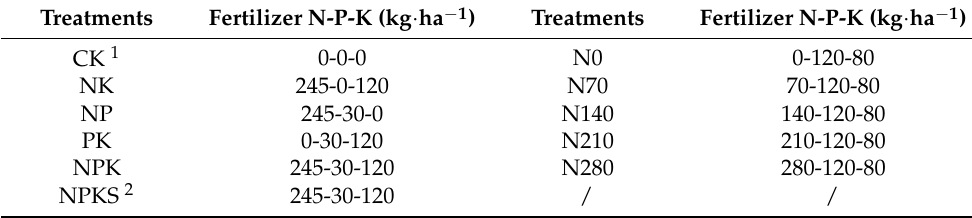
Table 1. NPK nutrient treatments in the WNCR and NBES fields.